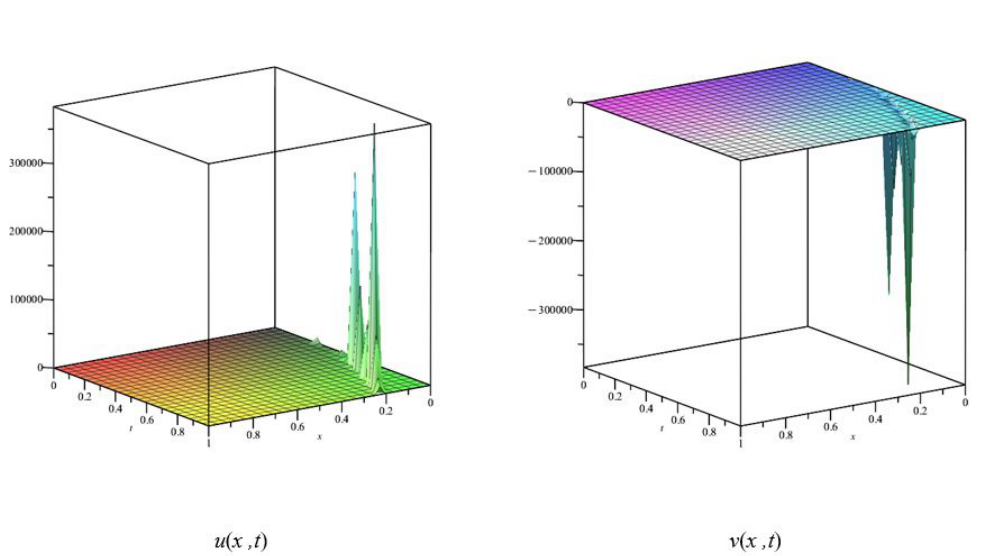
Figure 3. Graphical representations of Equations (27) and